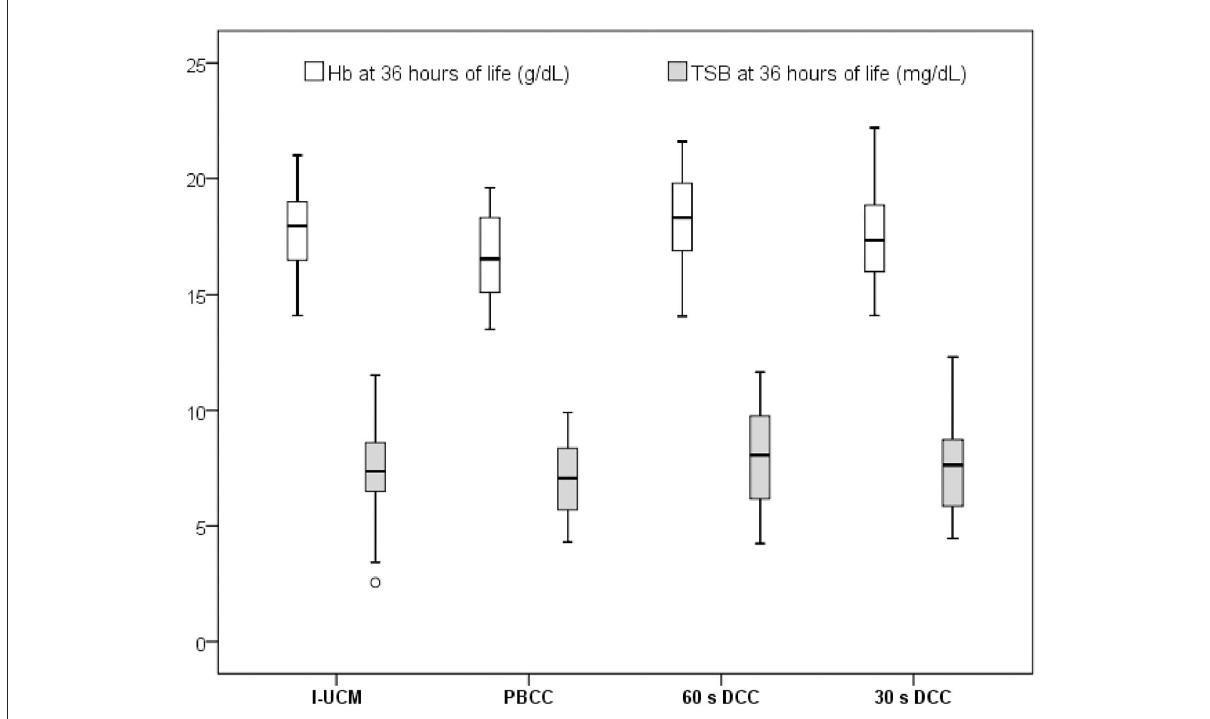
FIGURE1 Hemaglobin (Hb) and total serum bilirubin (TSB) levels at 36h of life